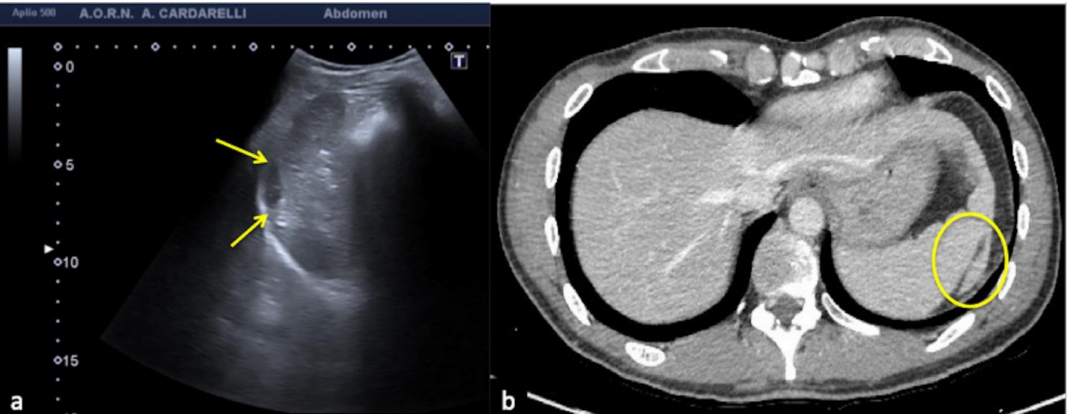
Figure 16. Coronal US scan of the left hypochondrium ( a ) shows a crescent-shaped hypoechoic area misinterpreted as hematoma (arrows) between the surface of the spleen and the left hemidiaphragm in a 25 − year-old man investigated for trauma. On CT scan ( b ) it appears to be a hypertrophy of the left hepatic lobe with splenic kissing (circle).